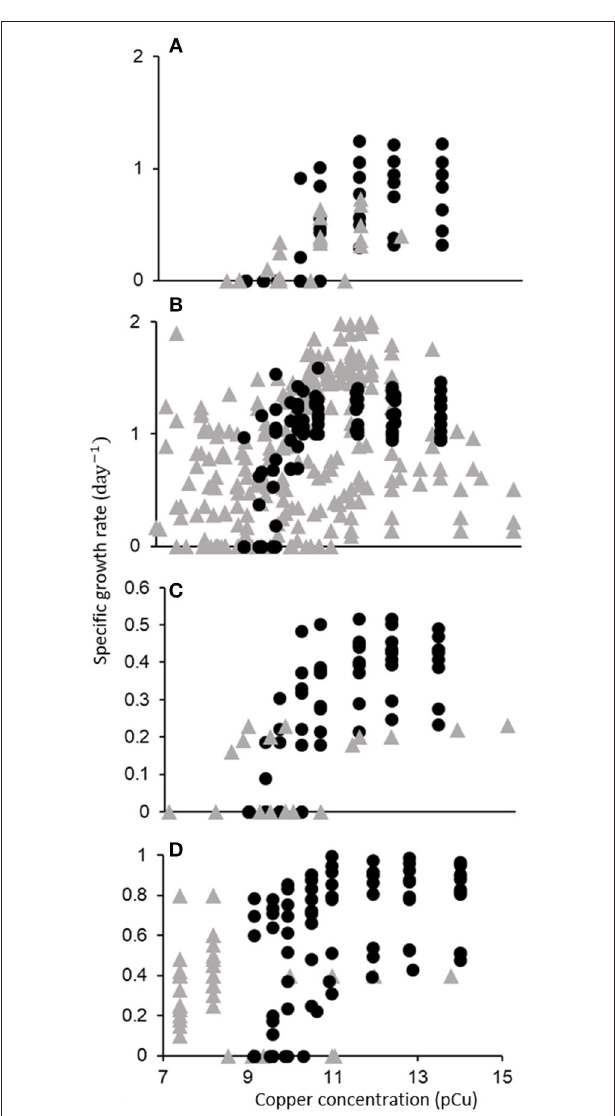
FIGURE 4 | Growth rate (d − 1 ) of major phytoplankton functional types as a function of pCu. Points represent single data points (one growth rate at one pCu) gathered from 44 publications. Data is categorized taxonomically: (A) Cyanobacteria, (B) Diatoms, (C) Dinoflagellates, and (D) Coccolithophores. Filled circles correspond to data from Brand et al. (1986), and shaded triangles correspond to data extracted from all other publications.